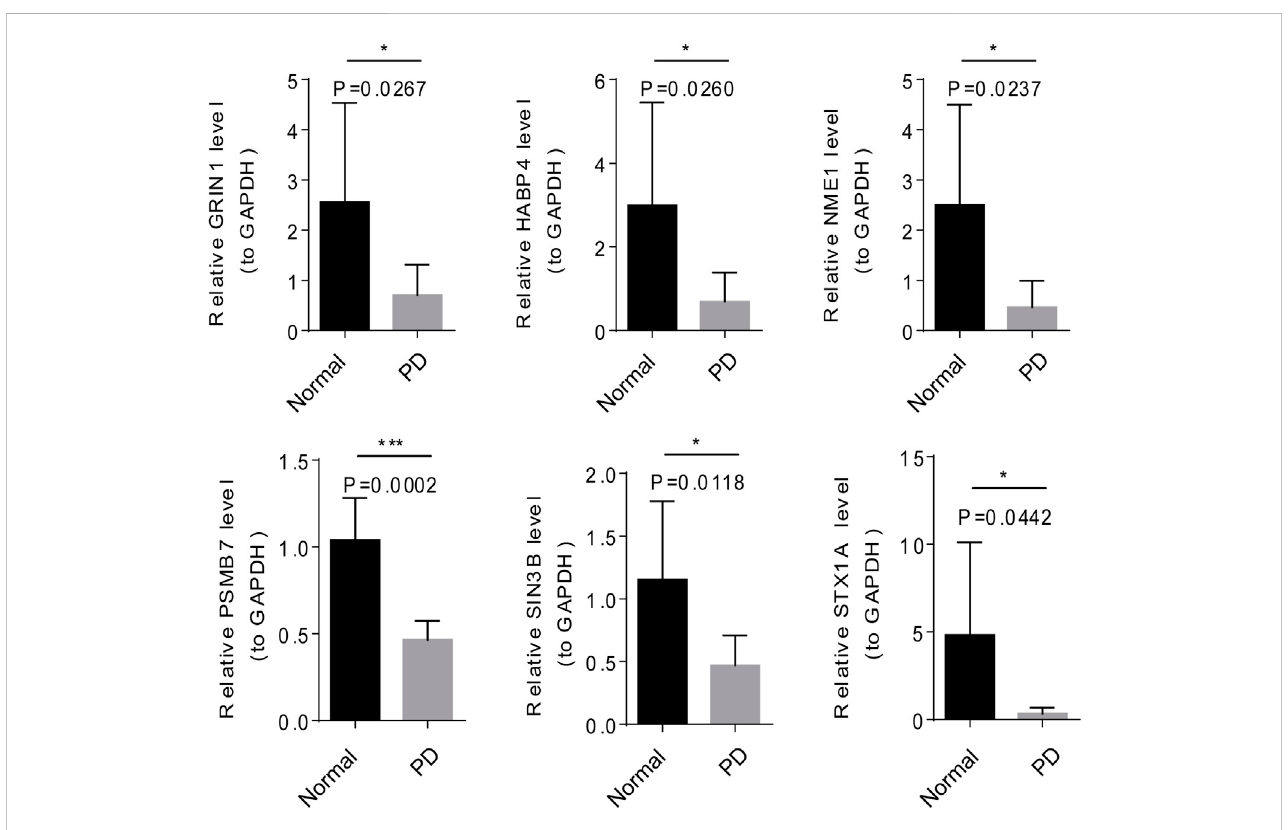
FIGURE 7 Veri fi cation of the mRNA expression of six modular genes by qRT-PCR and Western blot.